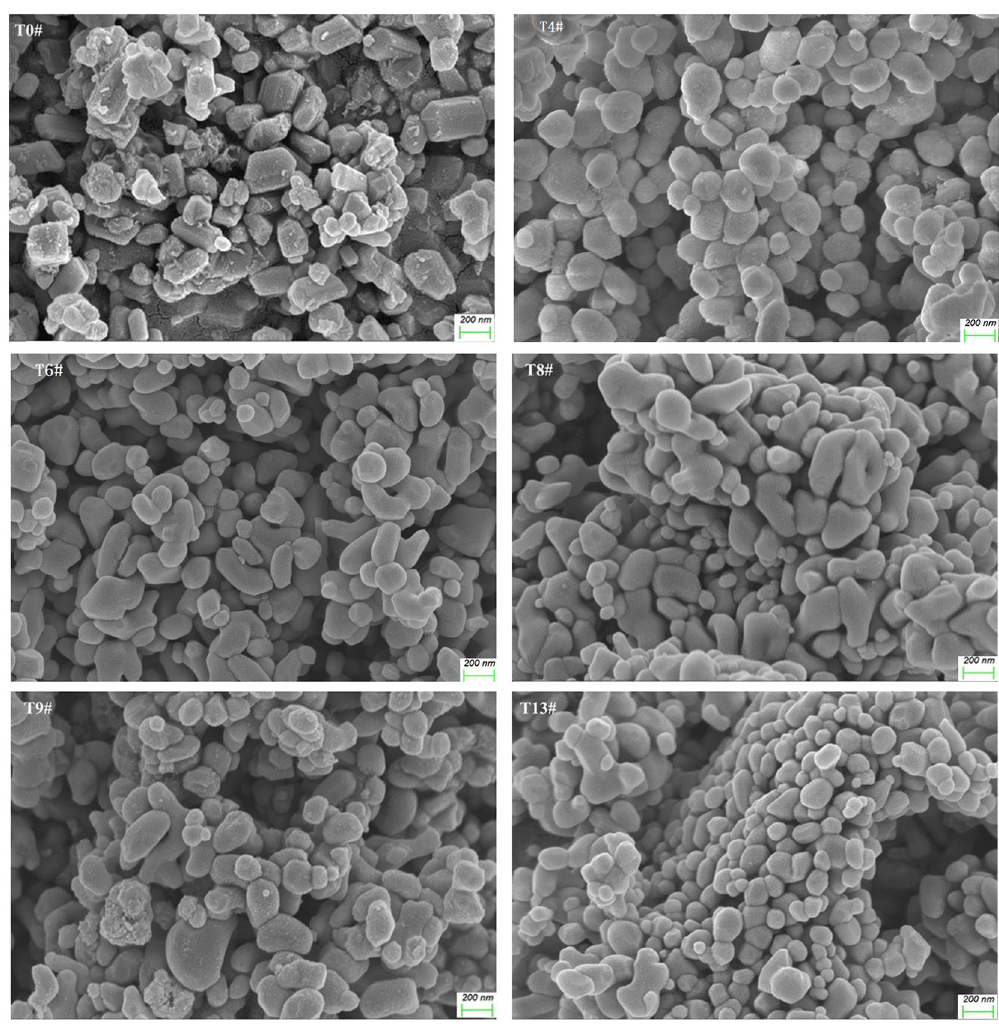
Figure 7. SEM photographs for the high purity TiO 2